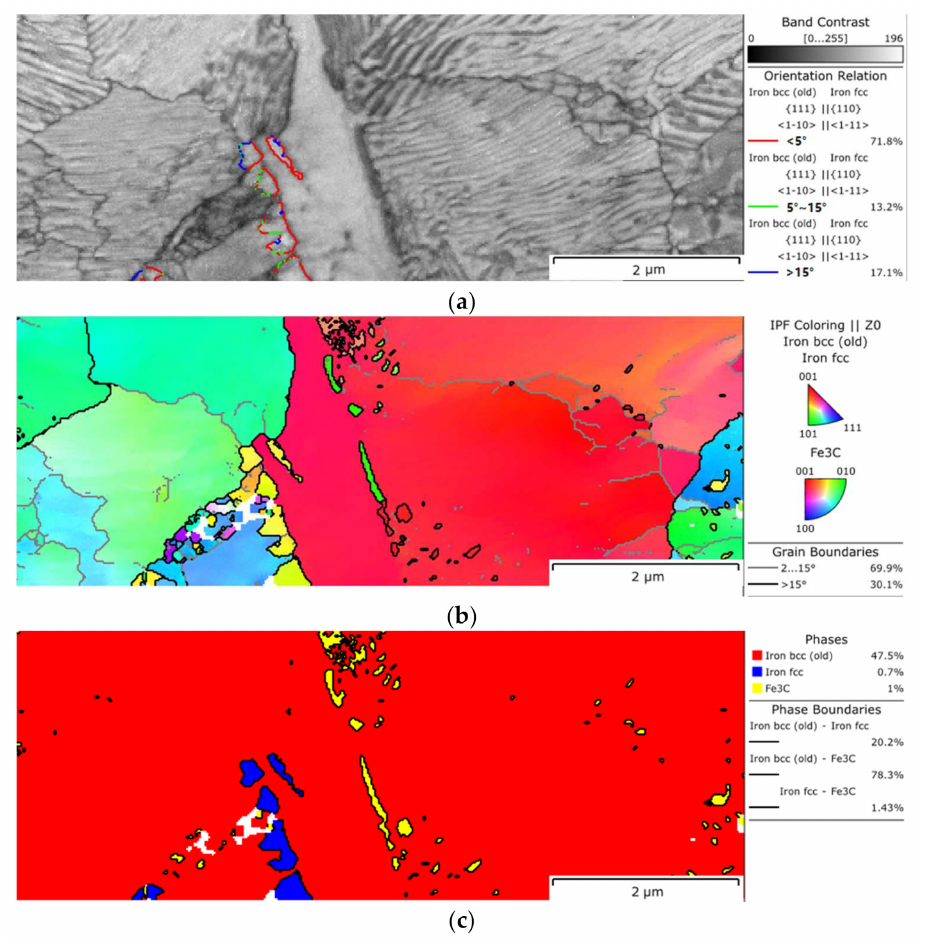
Figure 3. Microstructural analysis of sample transformed at 607 ◦ C for 15 s by TKD analysis: ( a ) SEM image and K–S orientation deviation (white, 0 ◦ –5 ◦ ; yellow, 5 ◦ –15 ◦ ; green, >15 ◦ ) and ( b ) corresponding orientation map; ( c ) corresponding phase map.